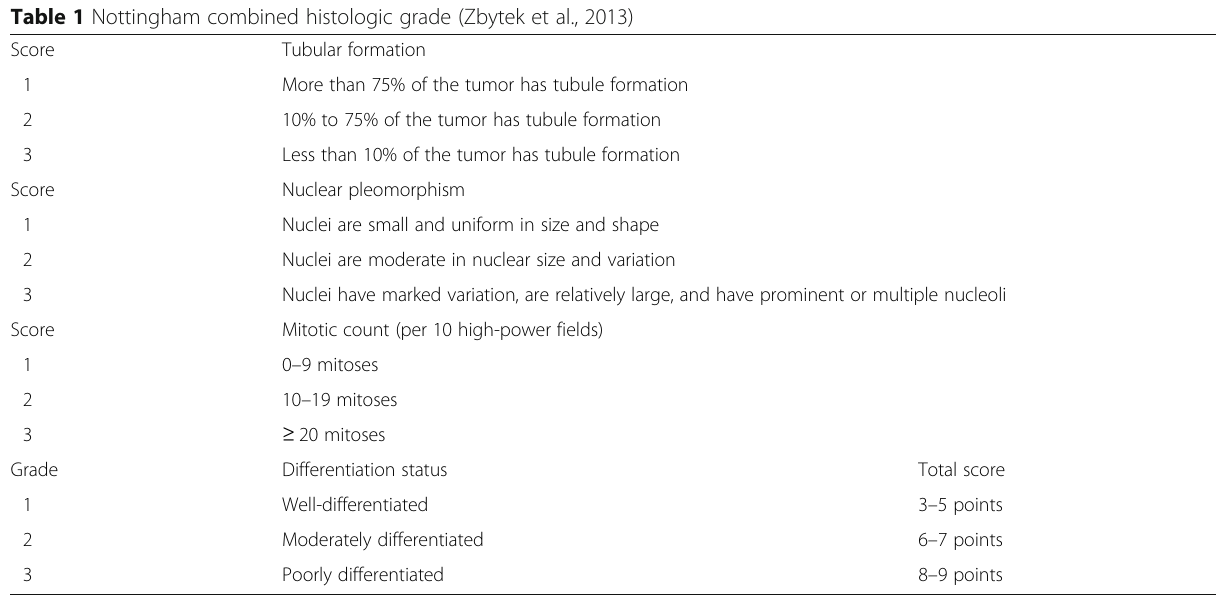
Table 1 Nottingham combined histologic grade (Zbytek et al., 2013)